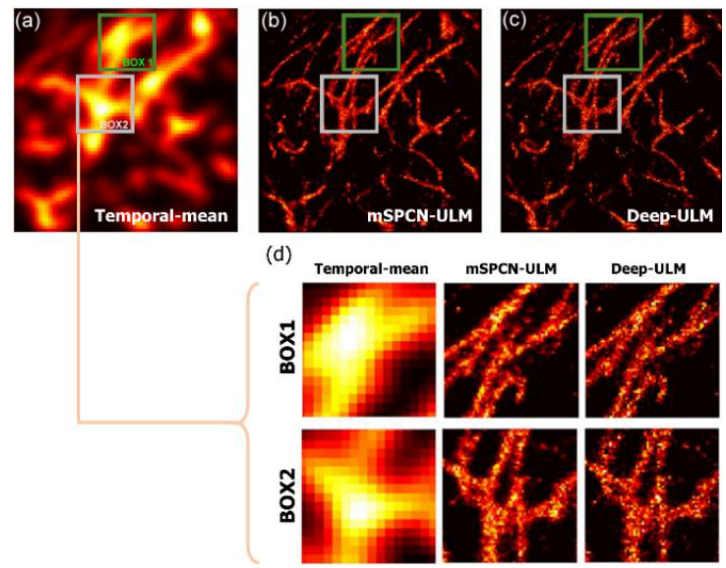
Figure 4. Comparison between mSPCN-ULM [40] and Deep-ULM [39]. ( a ) The temporal–mean image was obtained by averaging all the US images. ( b ) Super-resolution images obtained by the mSPCN-ULM. ( c ) Deep-ULM. ( d ) The magnified sections of ( a – c ) [40]. (Reprinted with permission from Ref. [40]. Copyright 2020 IEEE).